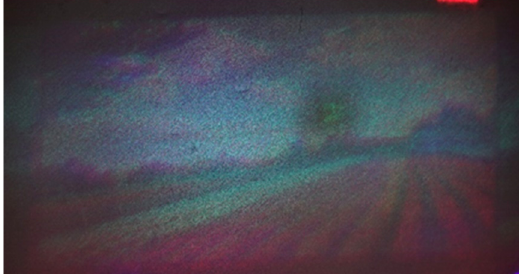
Figure 8. Optical reconstruction image with color unevenness corrected. The brightness and contrast were adjusted to make the reconstructed image clearer.